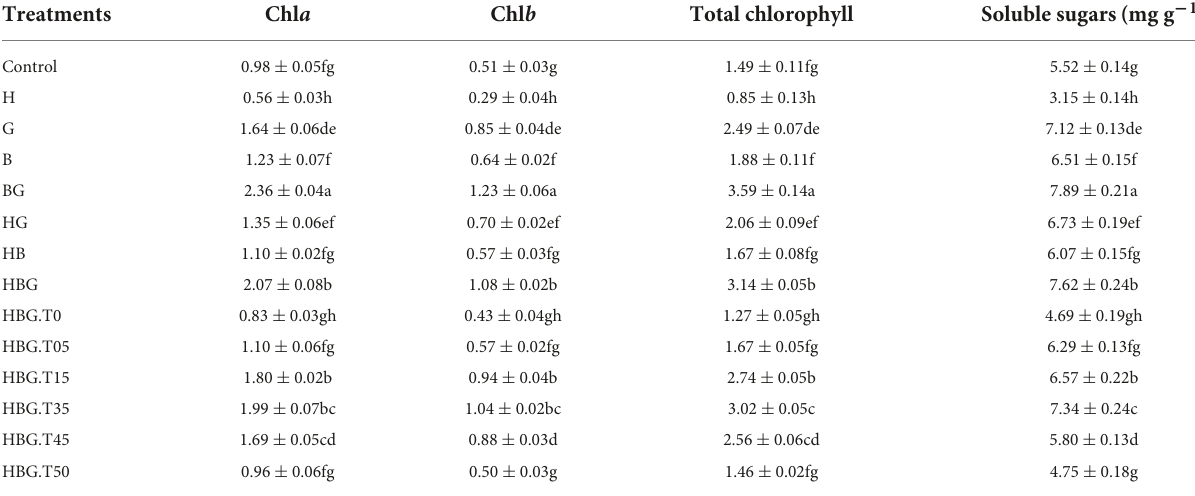
TABLE 1 Effect of GA 3 on chlorophyll a , chlorophyll b , total chlorophyll, and soluble sugars of Brassica alboglabra under temperature stress, and hexachlorobenzene (HCB) toxicity.